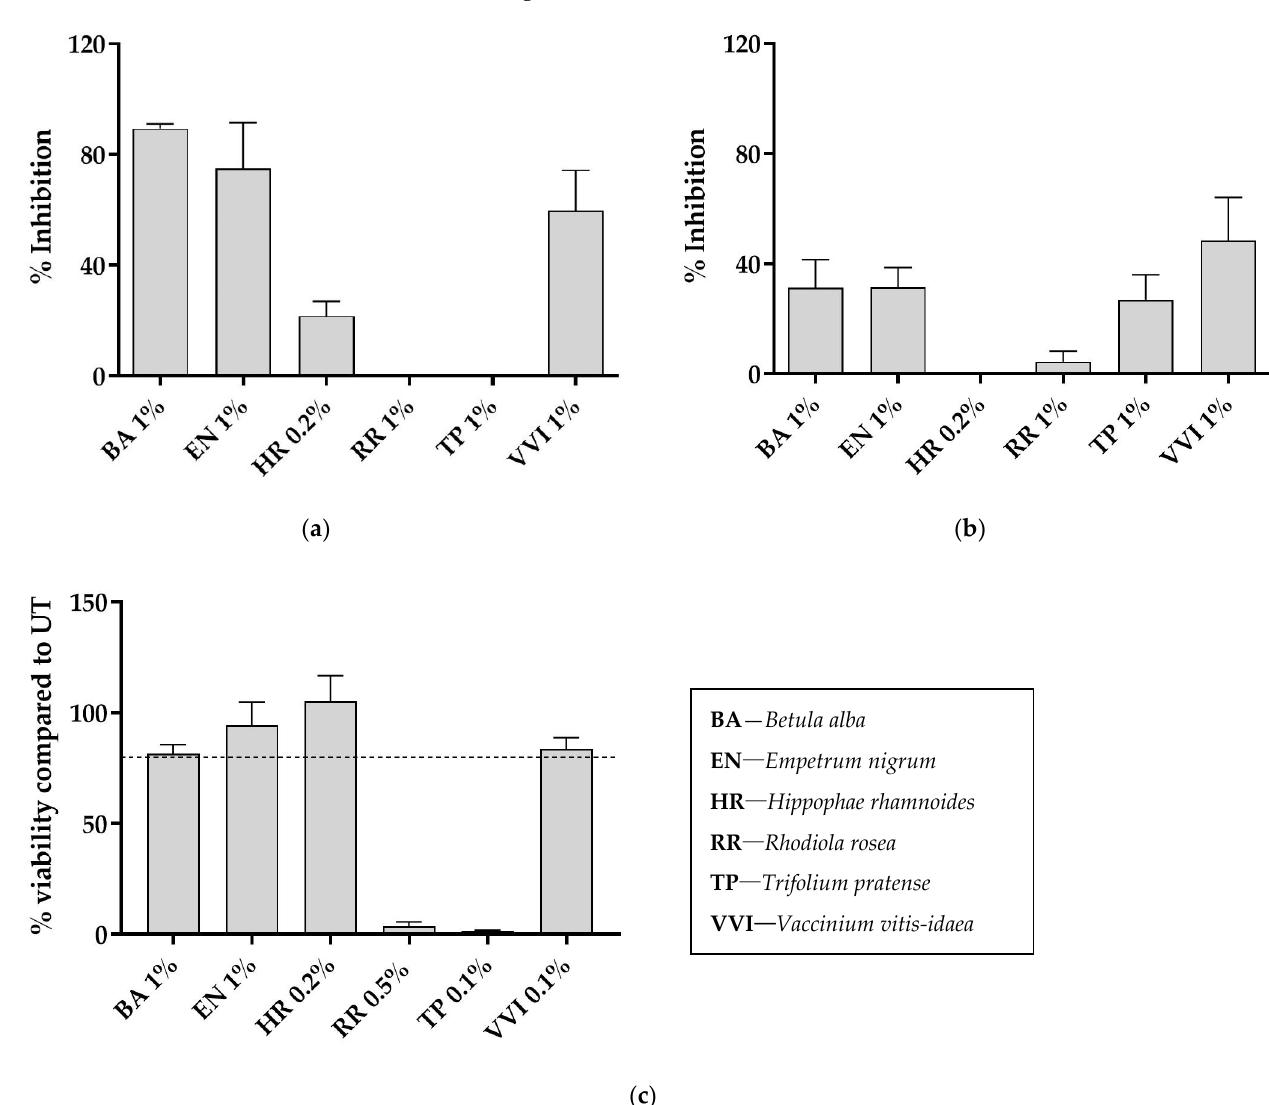
Figure 1. Screening results for the six extracts in ( a ) KLK5 inhibition assay ( n = 2); ( b ) hyaluronidase inhibition assay ( n = 2); and ( c ) viability assay ( n = 3), where the dotted line represents 80% viability, which was the qualified test requirement for cytotoxicity. Values are displayed as mean (±SD). Hyaluronidase is an enzyme that breaks down hyaluronic acid. Less hyaluronic acid leads to dehydrated skin and weakens the skin barrier [22]. The results from the screen showed that the strongest hyaluronidase inhibition was exhibited by VVI (49% ± 16%), with moderate inhibition by EN (31% ± 7%), BA (31% ± 10%) and TP (27% ± 9%) at 1% extract, Figure 1b.